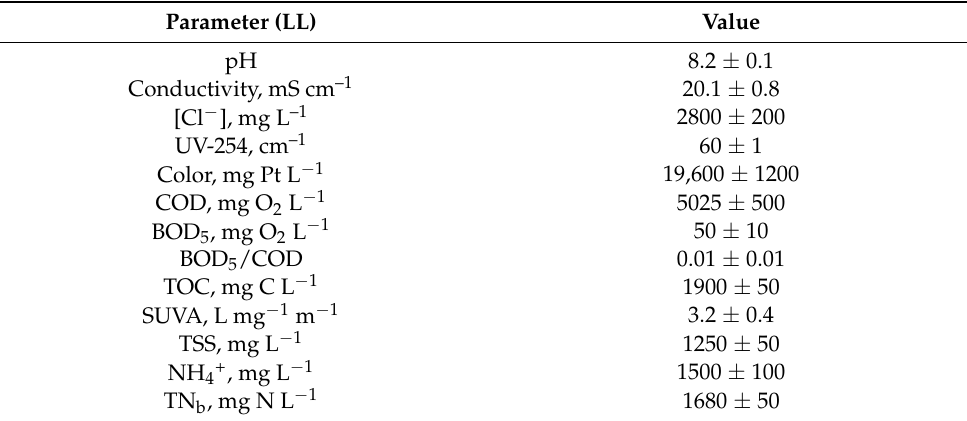
Table 1. Landfill leachate